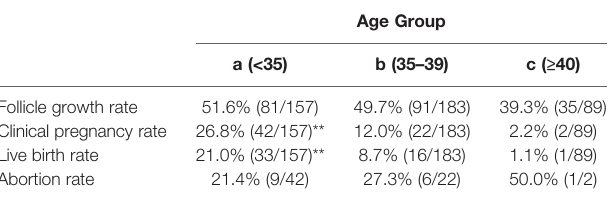
TABLE 2 | Follicle growth, clinical pregnancy, and live birth rates in Group OS classi fi ed by age at initiation of follow-up.